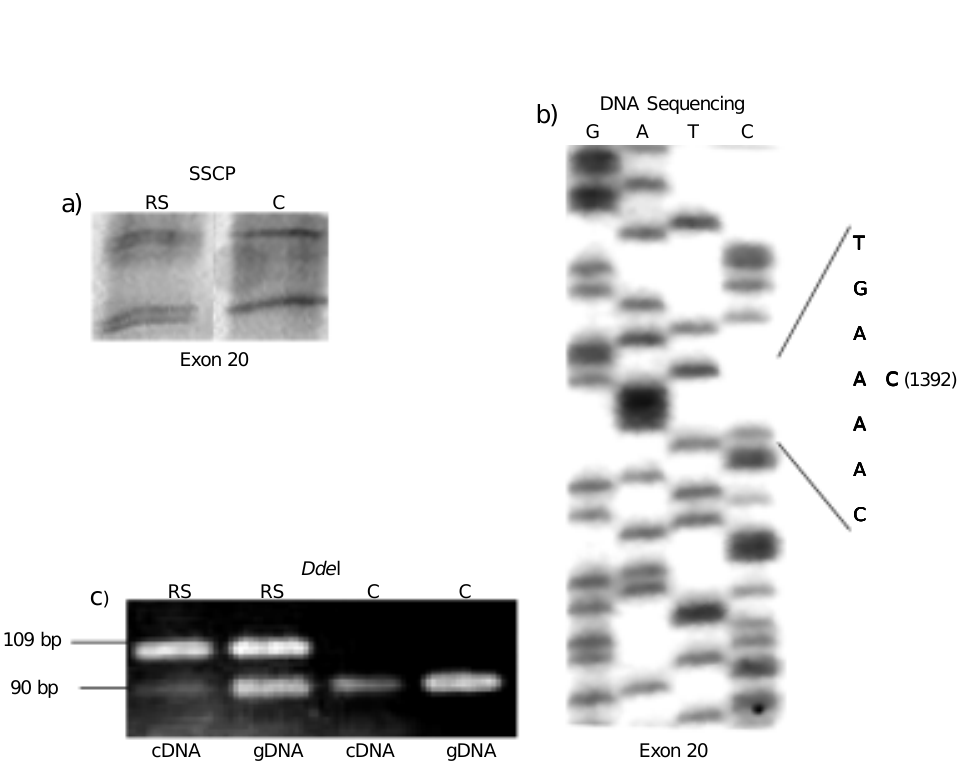
Figure 1. a , Family pedigree showing affected members for three generations. Splenecto- mized individuals are indicated by an asterisk and the proband is indicated by an arrow. b , Ex- ponential gradient (3.5 to 17%) SDS-polyacrylamide gel of total membrane proteins stained with Coomassie blue, showing a re- duction of spectrin content in the patient (RS) compared with the control (C). c , Blood smear from the propositus showing regular numbers of spherocytes and acanthocytes (arrows).